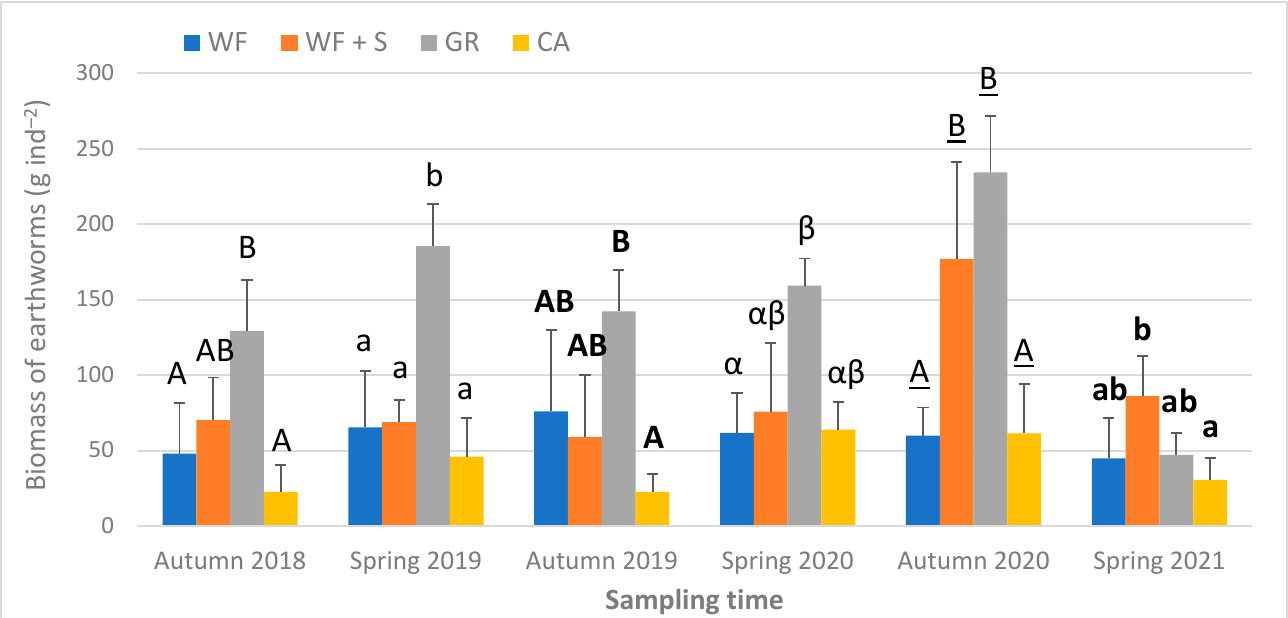
Figure 9. Earthworm biomass between autumn 2018 and spring 2021. Same letters above bars mean no statistical difference. Results of each sampling times were analyzed separately from each other, so each set of results per sampling time was marked with a different type of letter. (WF: weed control fabric; WF + S: weed control fabric and straw; GR: grass vegetation; CA: cultivated alfalfa).